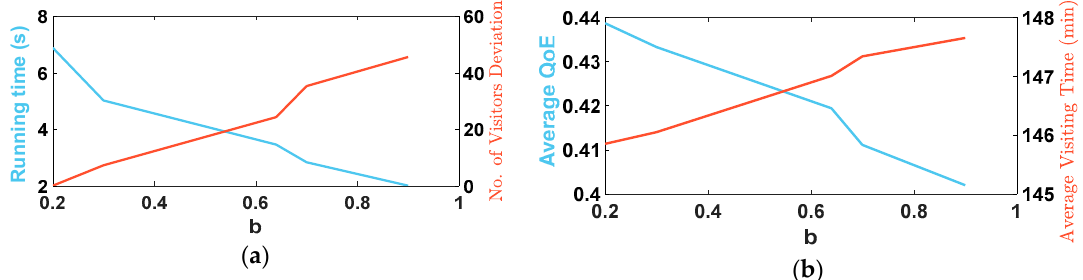
Figure 7. ( a ) RSVTM Running time and number of visitors’ deviation (with respect to b = 0.2) vs. learning rate b . ( b ) Average QoE and average visiting time vs. learning rate b .